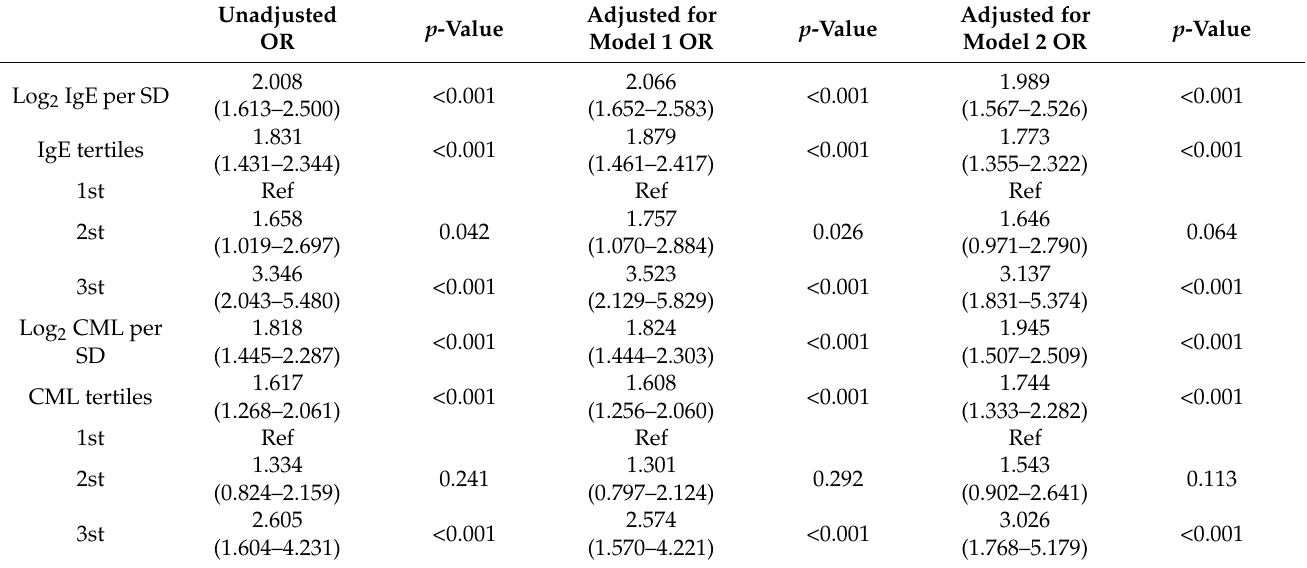
Table 3. Uni- and multi-variant regression